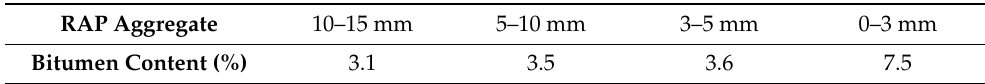
Table 3. Bitumen contents of different sizes of RAP aggregates.